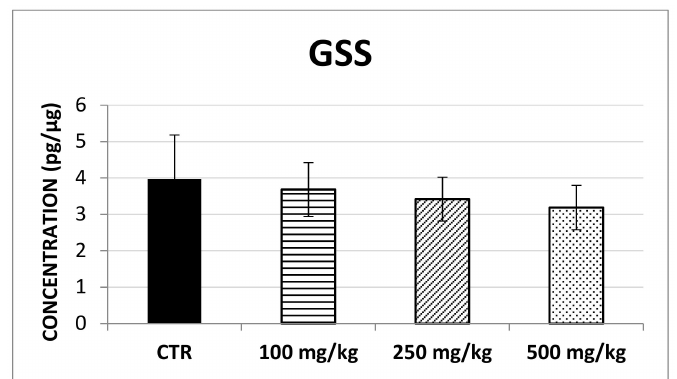
Figure 6. This histogram illustrates GSS concentration in control and treated groups. No significant differences could be found between